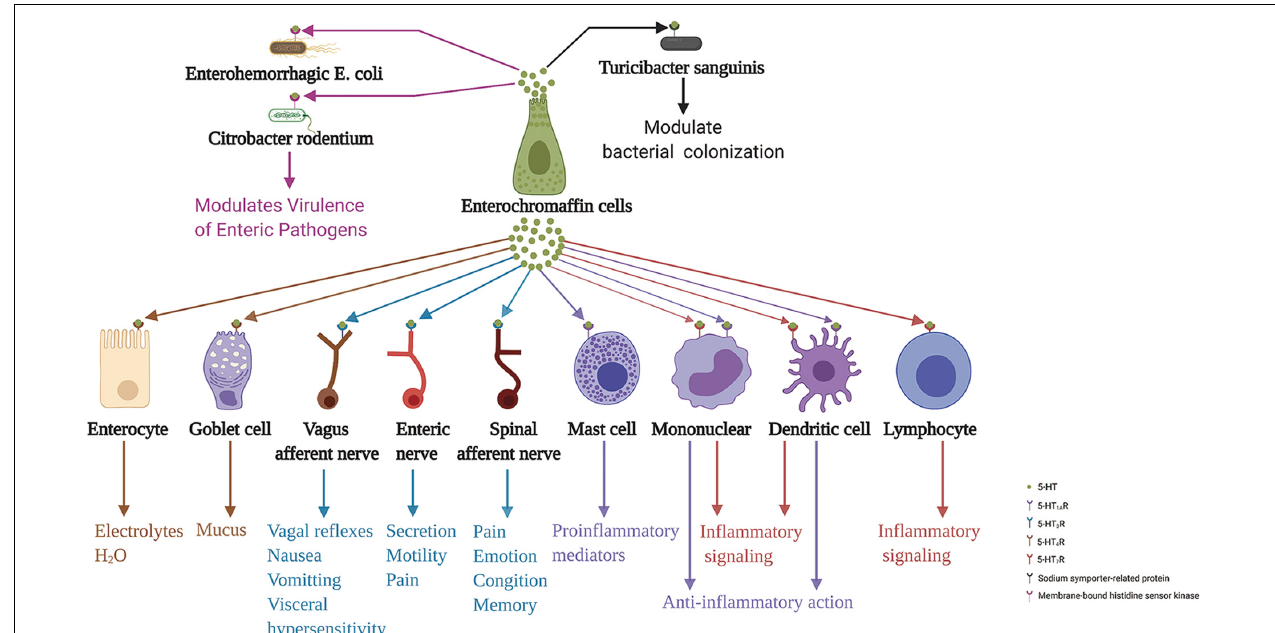
FIGURE 3 | Enterochromaffin cells action on various neighbor cells, neurons, and intestinal microbiota through released 5-HT. 5-HT acting on 5-HT 4 R stimulates epithelial cells to secrete electrolytes and H 2 O into the intestinal lumen and stimulates goblet cells to secrete mucus. Moreover, 5-HT acting on 5-HT 3 R of terminals of the spinal and vagus afferent nerves, and enteric nerves are involved in processes associated with emotion, cognition, memory, pain perception, distention- and chemical-evoked vagal reflexes, nausea, vomiting, visceral hypersensitivity, and intestinal functions, including secretion and motility. Furthermore, 5-HT acting on 5-HT 1A R induces mast cell adhesion, migration, and degranulation. In addition, 5-HT acting on 5-HT 7 R in immune cells, including monocytes, lymphocytes, and dendritic cells, may be implicated in inflammation signaling. In contrast, 5-HT acting on 5-HT 1A R in monocytes and dendritic cells has an anti-inflammatory role. In addition to these functions, 5-HT action on 5-HT receptors of enteric bacteria, sodium symporter-related protein of Turicibacter sanguinis , and membrane-bound histidine sensor kinase of enterohemorrhagic Escherichia coli and Citrobacter rodentium , play a crucial role in modulating bacterial colonization and virulence of enteric pathogens. 5-HT, serotonin; 5-HTR, serotonin